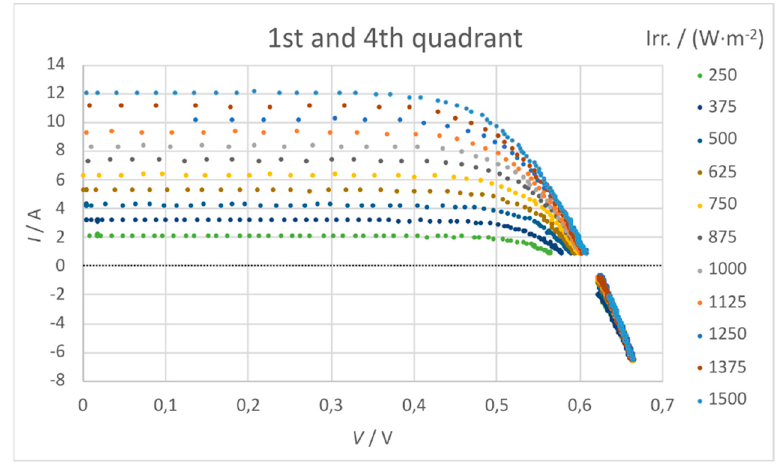
Figure 20. Three-quadrant I-V curves measured with the prototypes at different irradiances from 250 to 1500 W/m 2 .